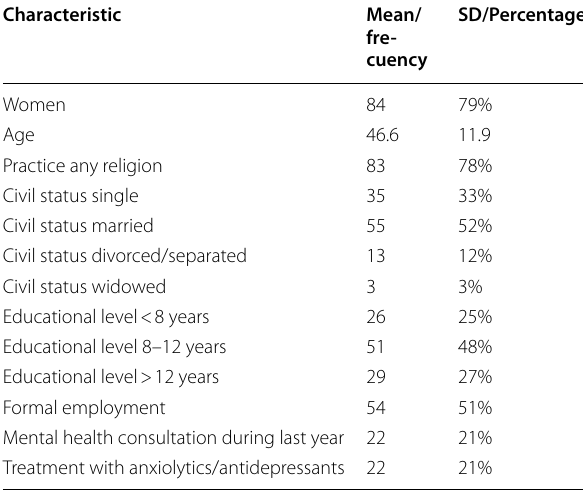
Table 1: Socio-demographic characteristics of the